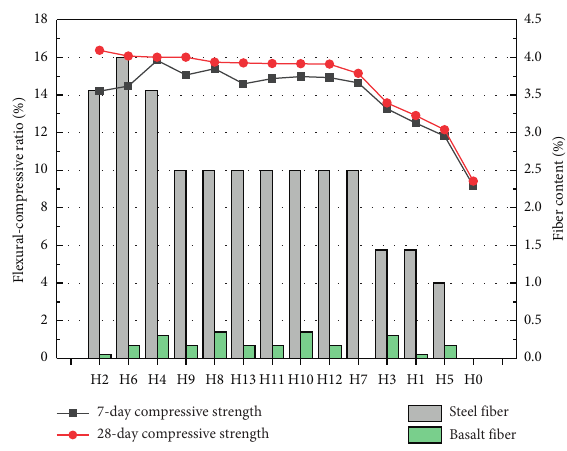
Figure 11: Flexural-compressive ratio